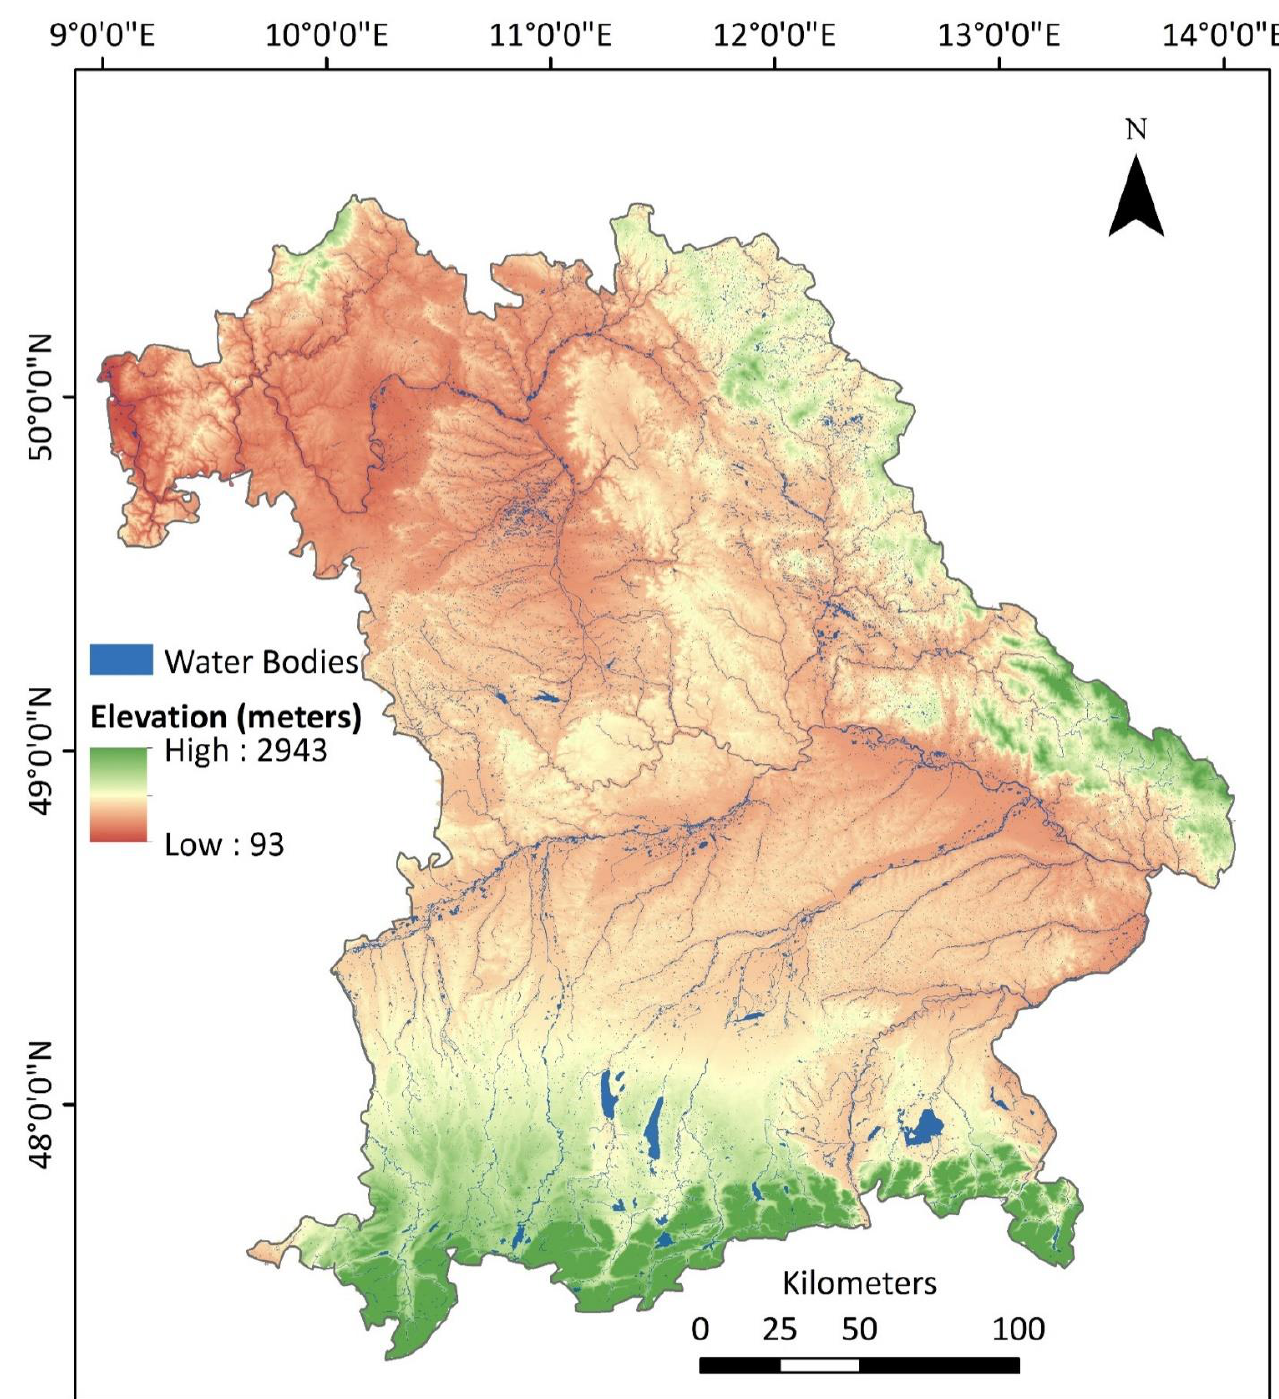
Figure A2. The digital elevation map of Bavaria. The map is generated from shuttle radar topography mission (SRTM) digital elevation data. The elevation ranges from 93 m to 2943 m.